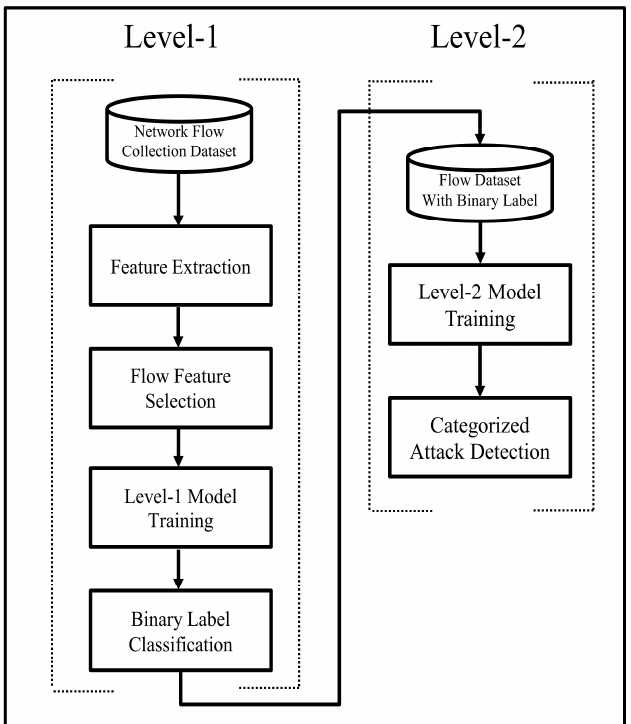
Figure 4. Two-Level Flow-Based Anomalous Activity Detection System Intrusion Detection in IoT Networks.